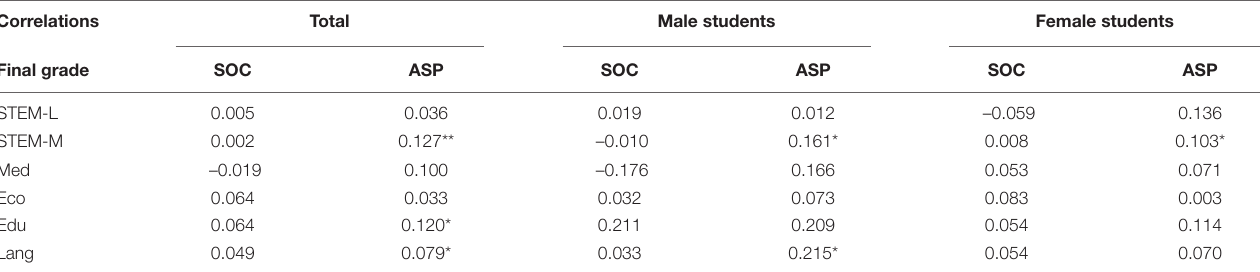
TABLE 4 | Correlations of social congruence (SOC) and aspirational congruence (ASP) with grades for all students (Total) and separate for male and female students for the different subject areas.